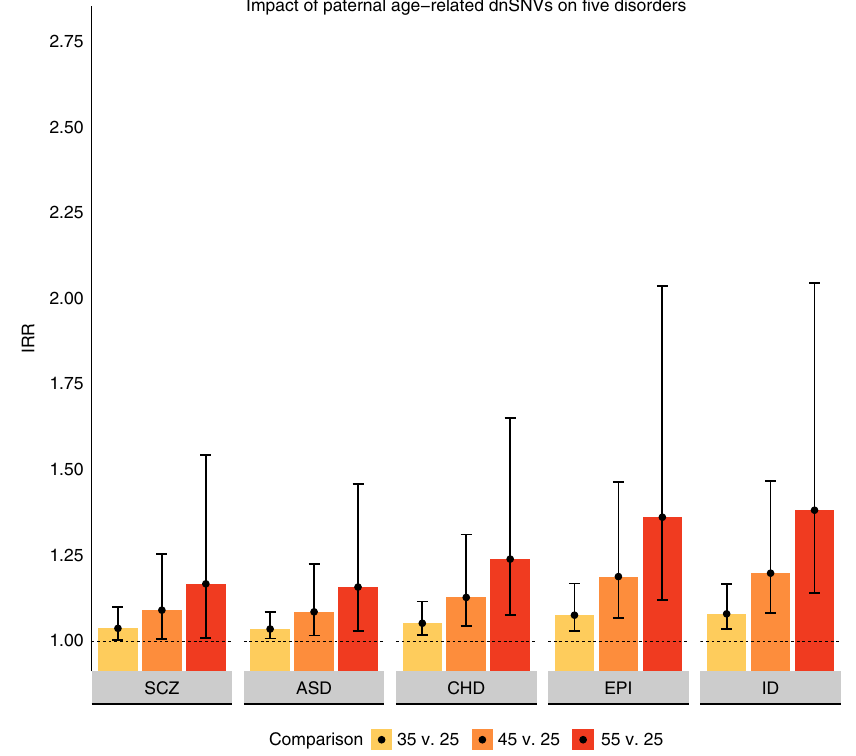
Fig. 1 Impact of paternal age-related dnSNVs on fi ve disorders. IRR Incidence rate ratio, SCZ schizophrenia, ASD autism spectrum disorder, CHD congenital heart disease, EPI epilepsy, ID intellectual disability. Error bars re fl ect 95% con fi dence intervals. Note that con fi dence intervals are not valid for comparing dnSNV effect within or across disorders (See